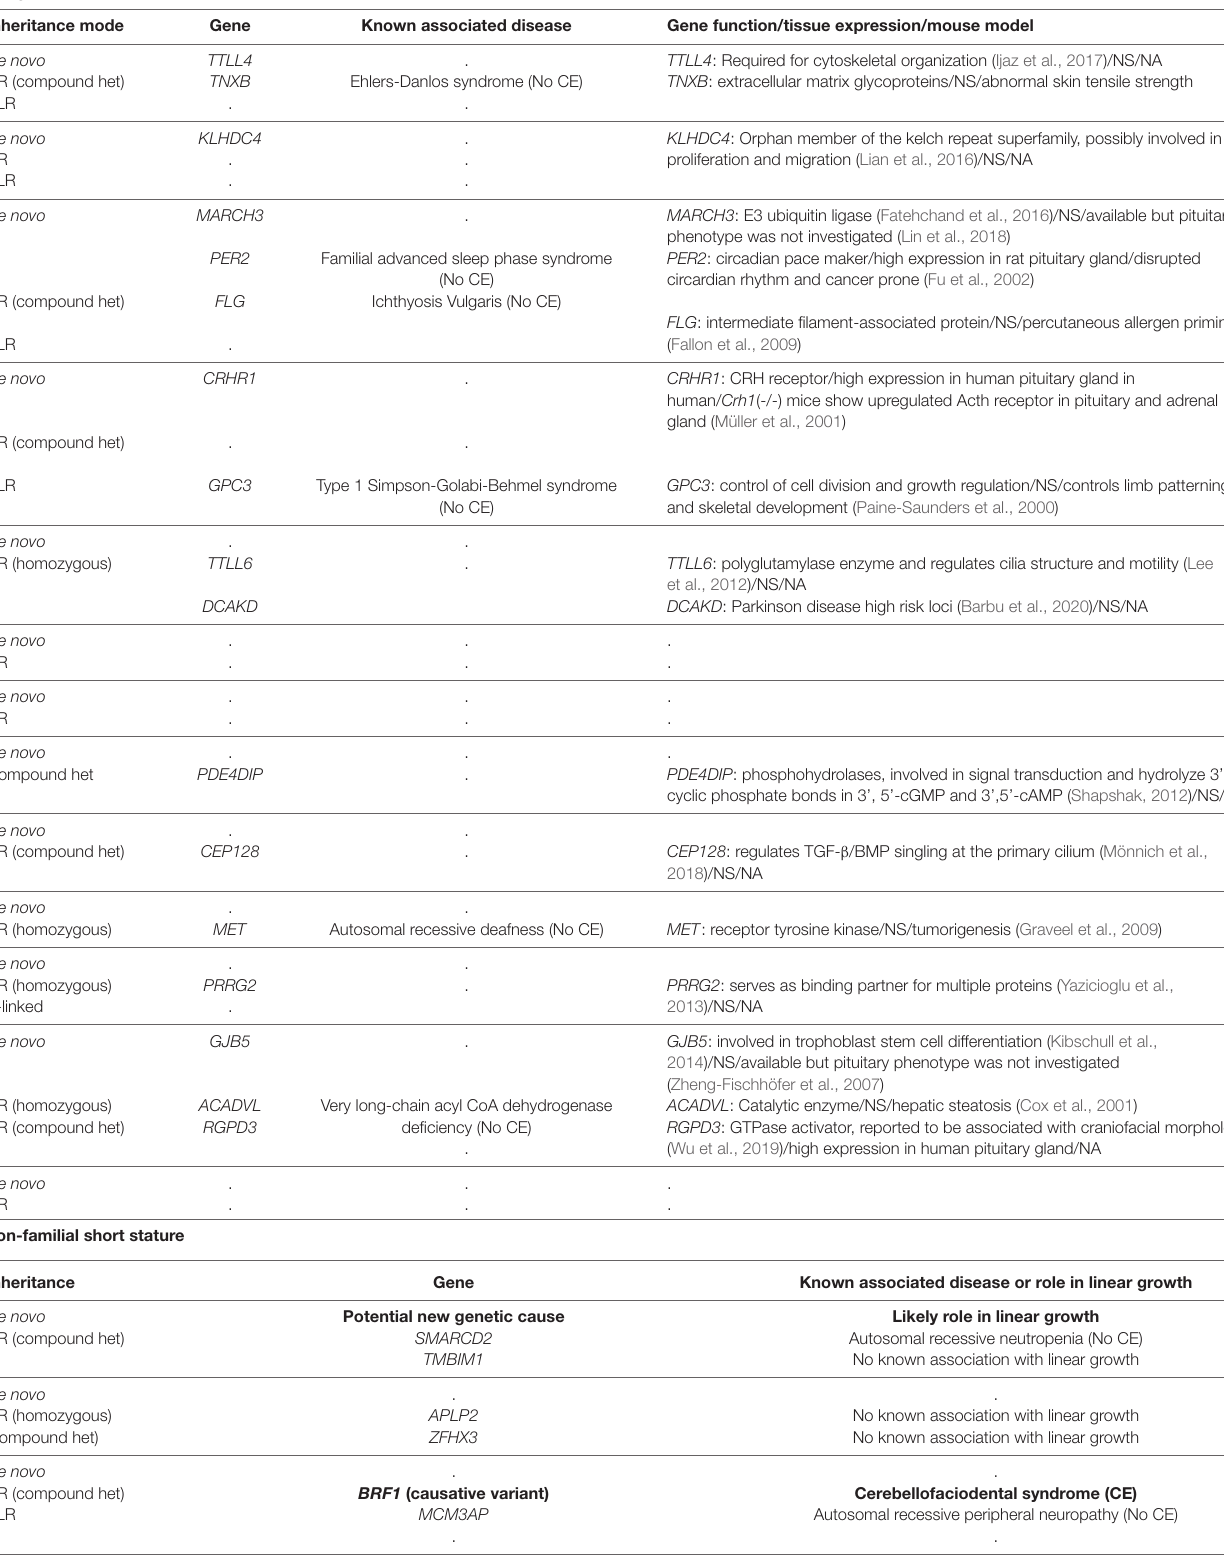
TABLE 4 | Candidate monogenic variants. Congenital hypopituitarism Inheritance